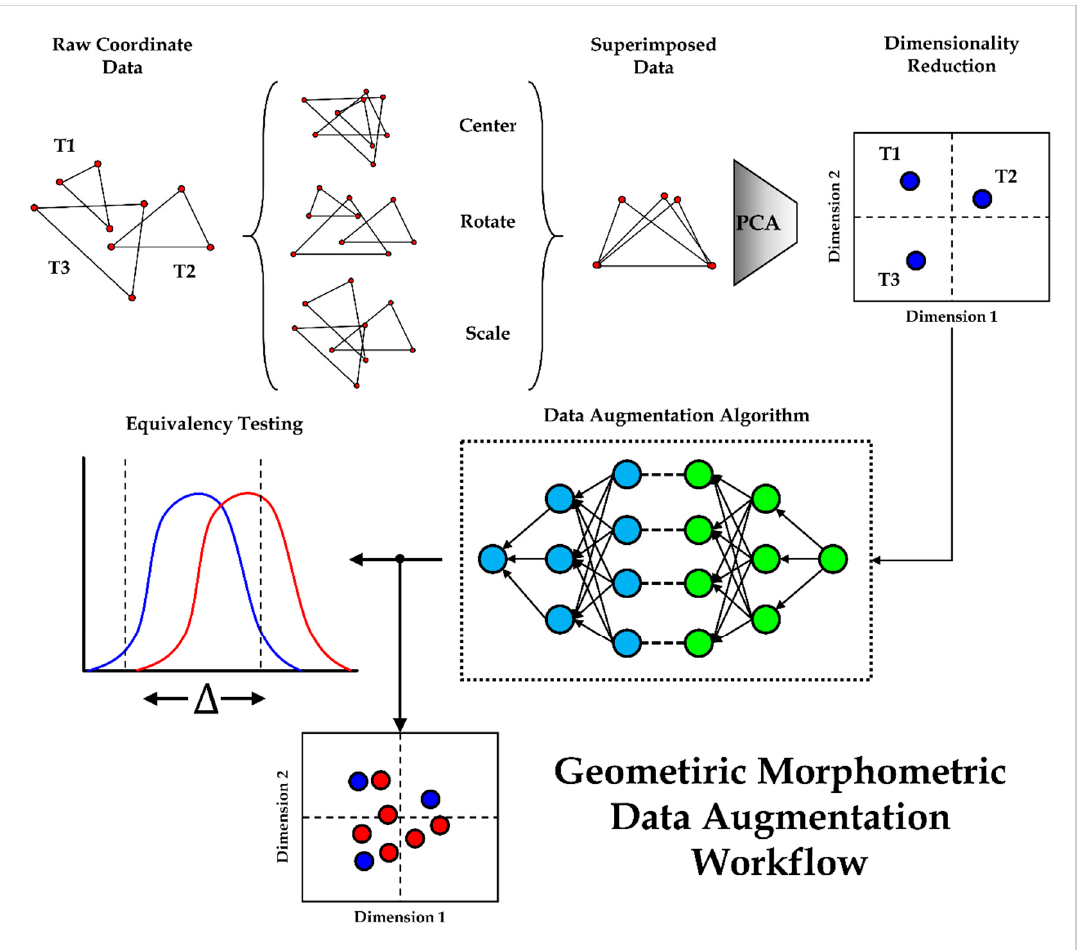
Figure 2. Workflow proposed for data augmentation tasks in geometric morphometrics.